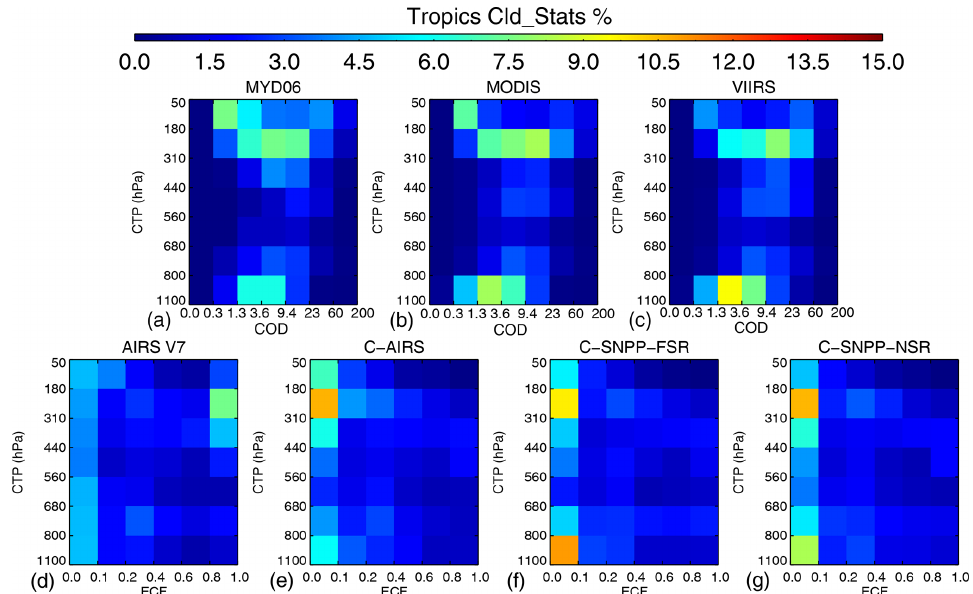
Figure 10. The two-dimensional histograms calculated using SNOs from the focus days in the tropics (30 ◦ N–30 ◦ S). (a–c) Results for MODIS and VIIRS, for which the ISCCP type of COD–CTP joint histograms are presented by summarizing the histograms over individual AIRS and CrIS FOV. Note that no averaging over sounder FOV is taken for this comparison. From left to right, results of MYD06, Aqua MODIS continuity, and SNPP VIIRS continuity cloud products. (d–g) Results for AIRS and CrIS and joint distributions are calculated on the imager effective CTP and ECF space. From left to right, data from AIRS version 7 (AIRS V7), CLIMCAPS-Aqua (C-AIRS), CLIMCAPS-